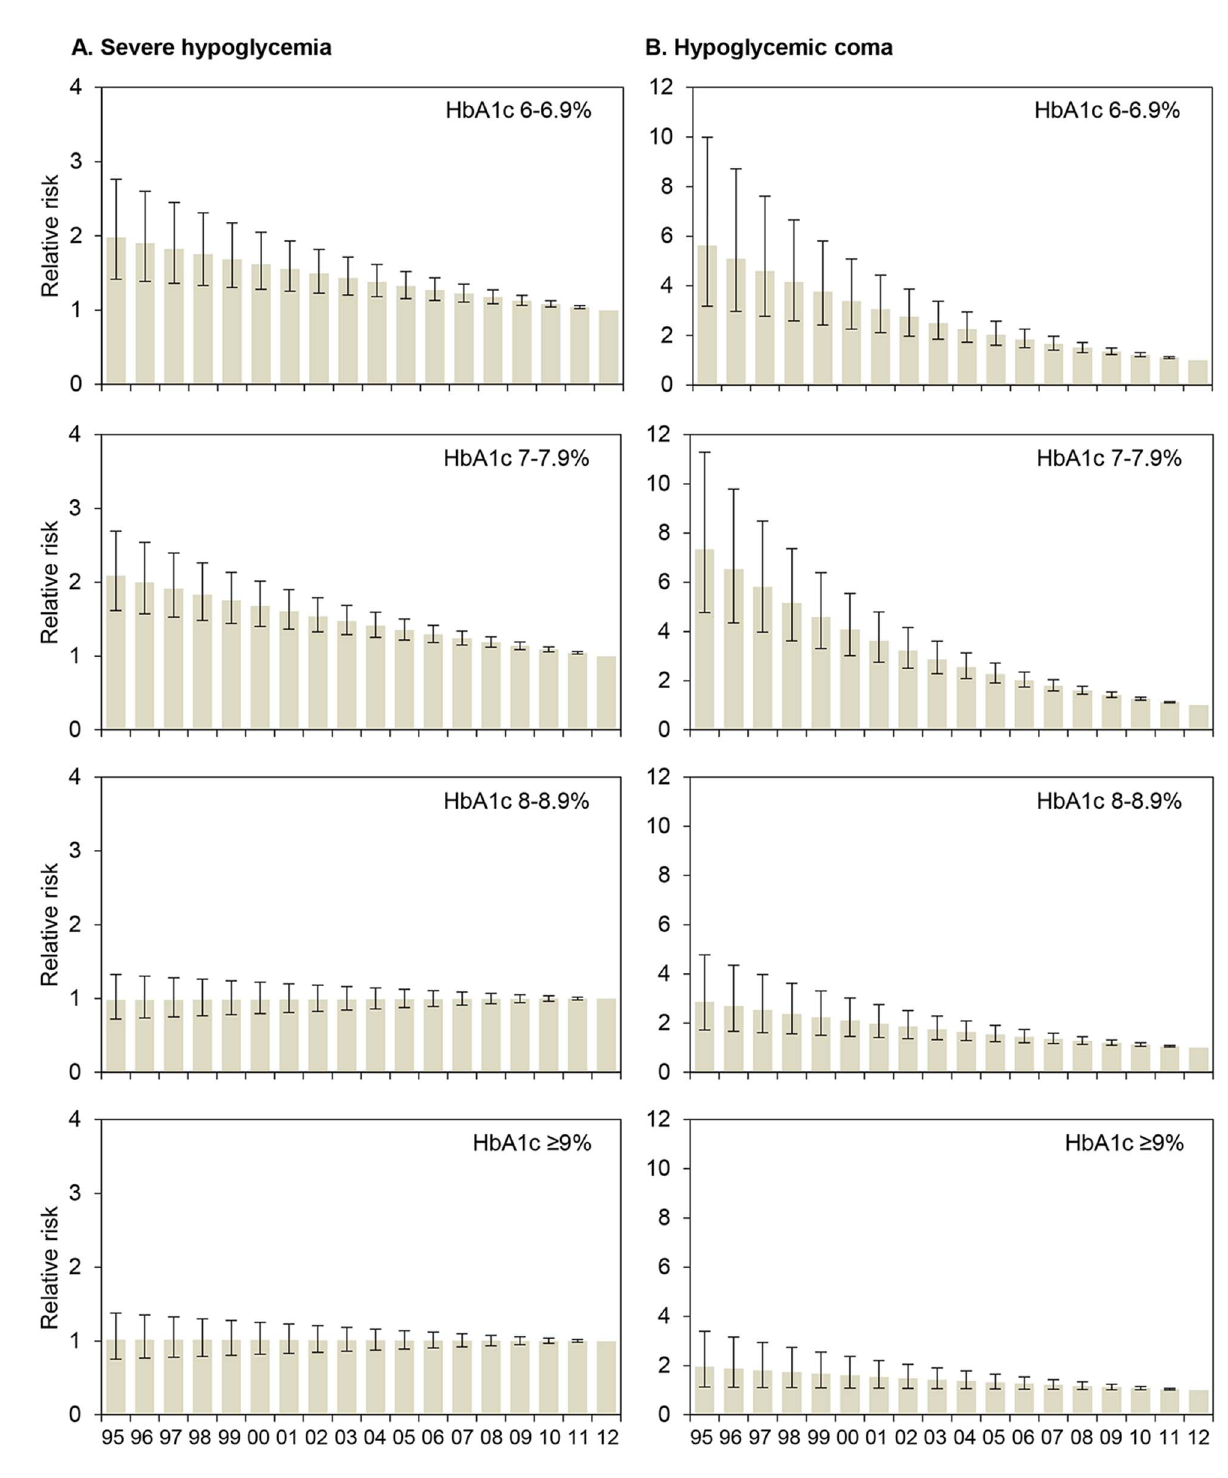
Figure 1. Relative risk for severe hypoglycemia and hypoglycemic coma by HbA1c category for each treatment year. RRs (with 95% CIs) are derived from regression analyses with severe hypoglycemia (A) or hypoglycemic coma (B) as the dependent variable, modeling treatment year ( x -axis) as a continuous term and HbA1c as a categorical term and including a term for interaction between treatment year and HbA1c, adjusted for sex, age, and diabetes duration. 2012 is the reference year (RR 1.0). Conversion for HbA1c [mmol/mol] = (HbA1c [percent] 2 2.15) 6 10.929.